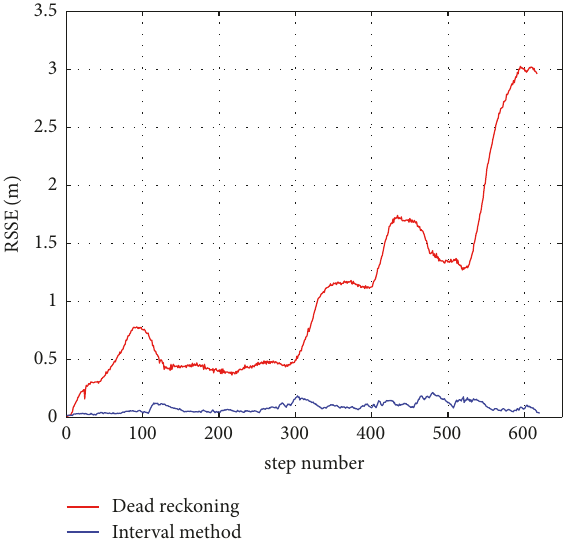
Figure 16: The error of localization results by DR and IA.